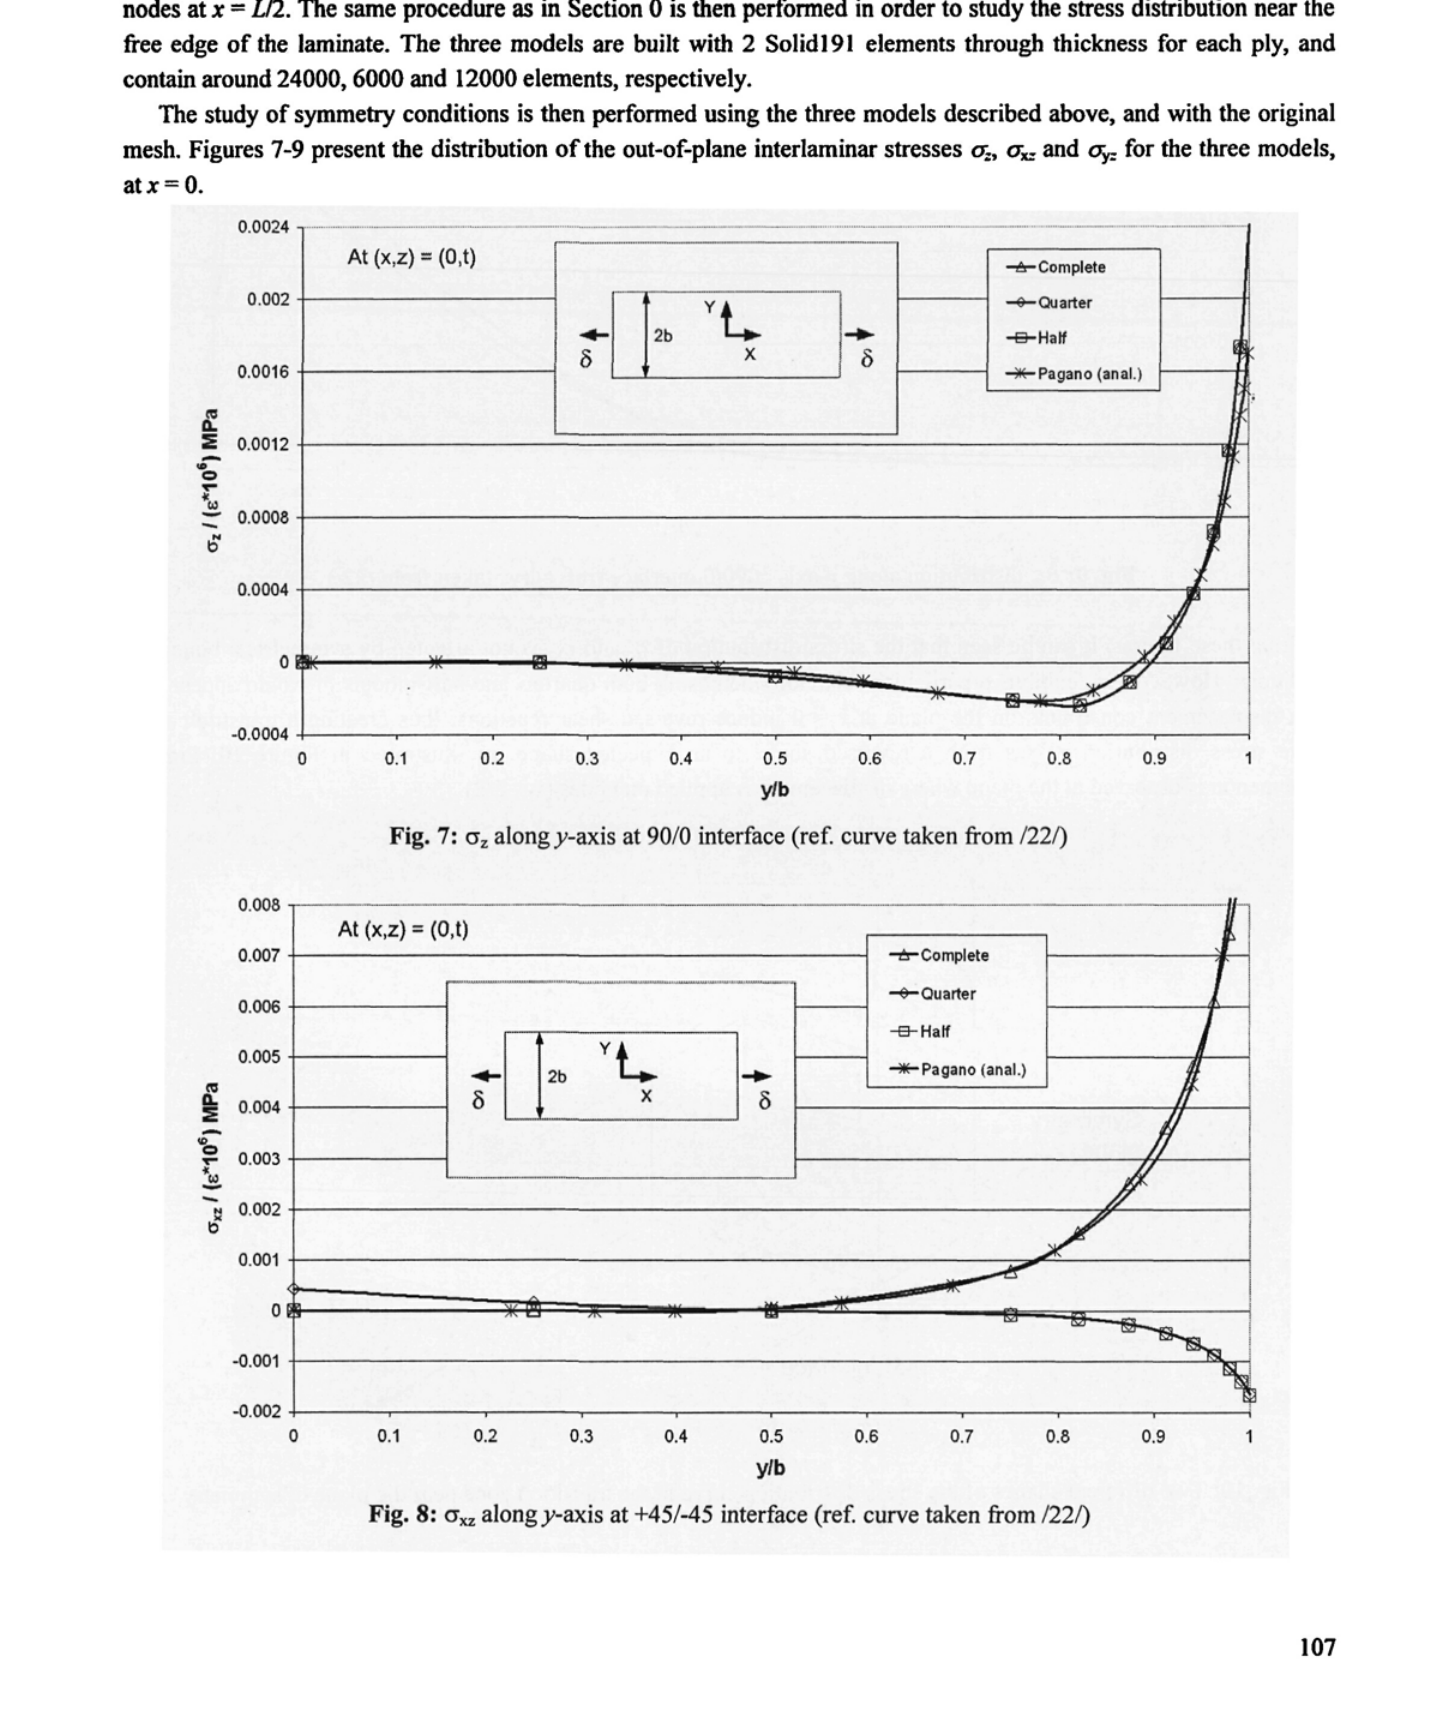
Fig. 7: σ along y-axis at 90/0 interface (ref. curve taken from 1221) ζ